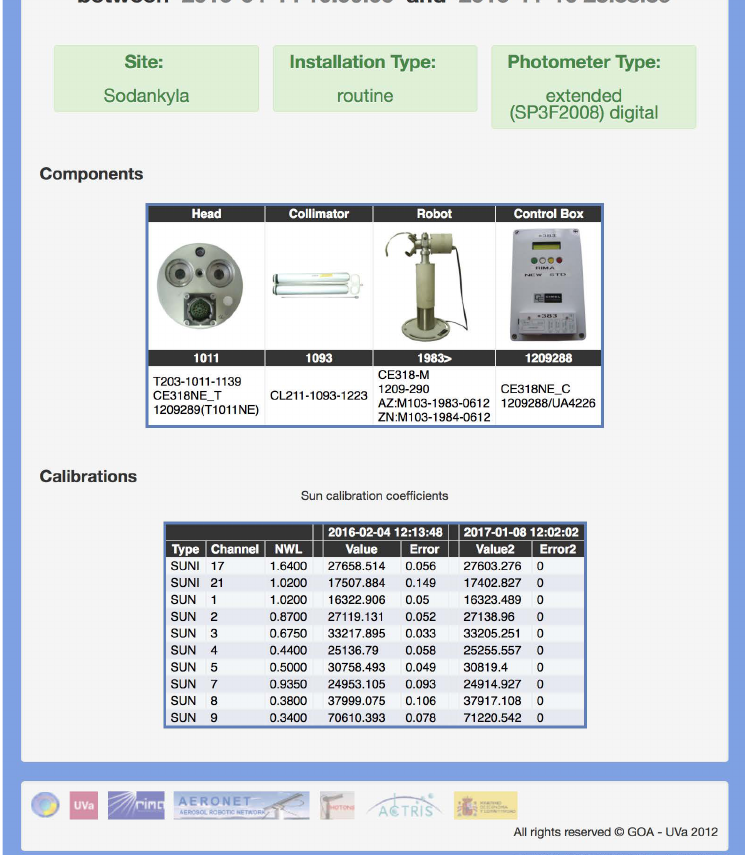
Figure 7. Screenshot (cut and abbreviated) of the photometer description for AERONET photometer